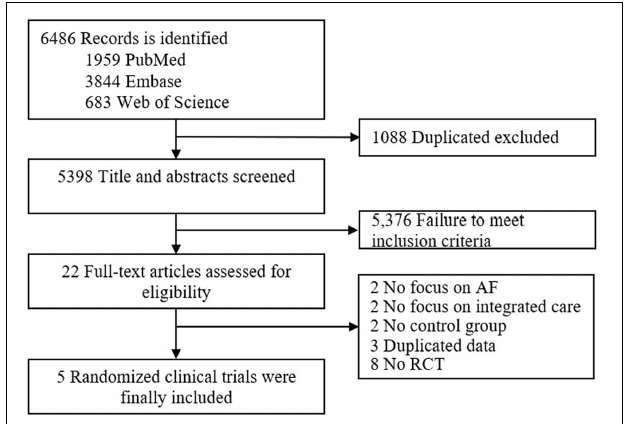
FIGURE 1 | Flowchart for publication